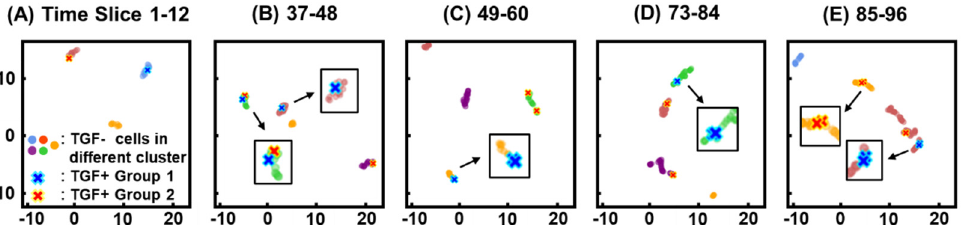
Figure 3. Visualization of cell tracks after dimensionality reduction. ( A – E ) 2D visualization of TGF (+) (“X” mark) and TGF ( − ) cell (colored points) trajectories after dimensionality reduction by UMAP and clustering by k-means. Each mark and point represent a trajectory. Colors represent different clusters. The insets show the magnified images of TGF (+) cells when they overlap ( B – E ).